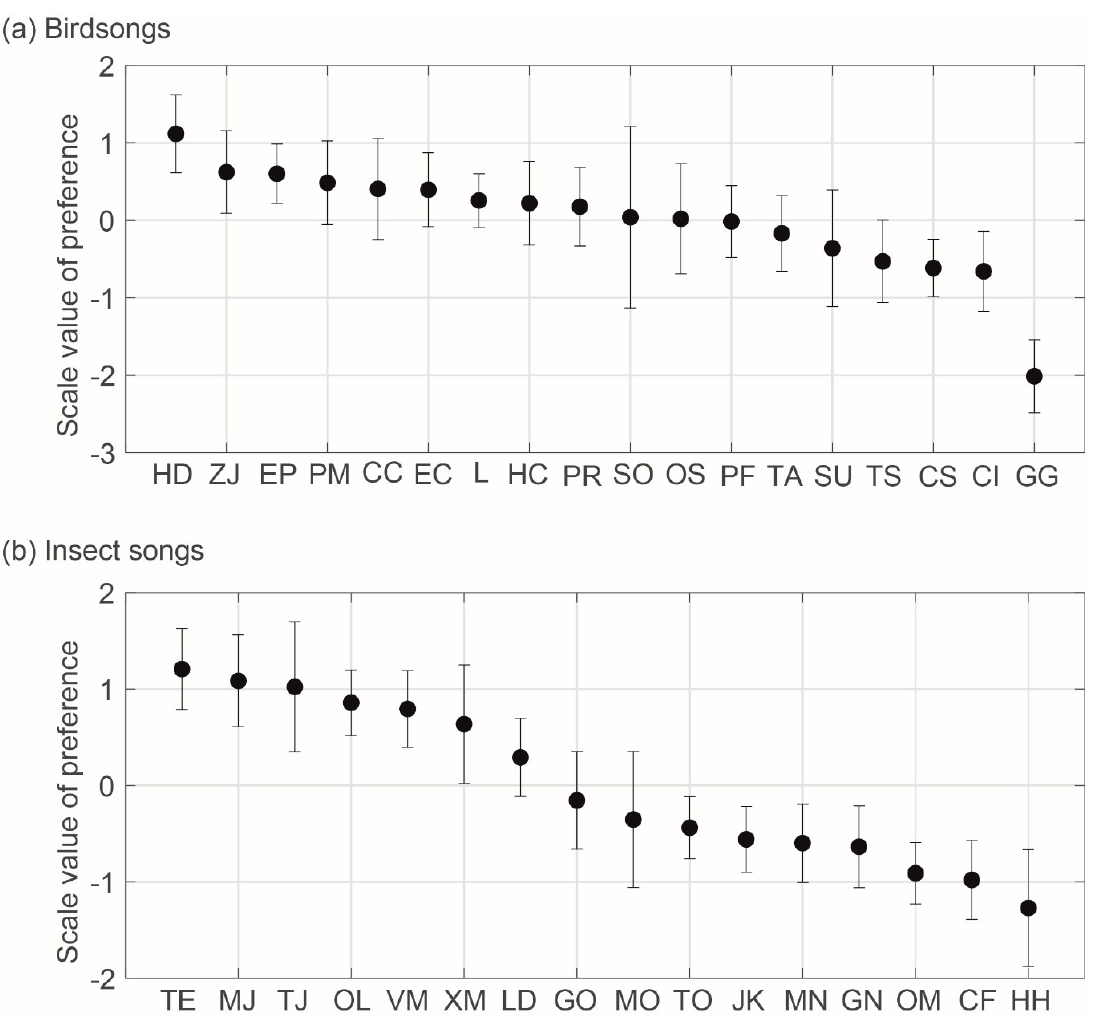
Figure 5. Scale values of preferences for ( a ) birdsong and ( b ) insect song. Each symbol indicates the mean value and error bars indicate standard deviations. Table 3. Correlation coefficients between each physical parameter and subjective preference for birdsongs and insect songs. Asterisks indicate the level of significance, i.e., ** p < 0.01, * p < 0.05. Parameter